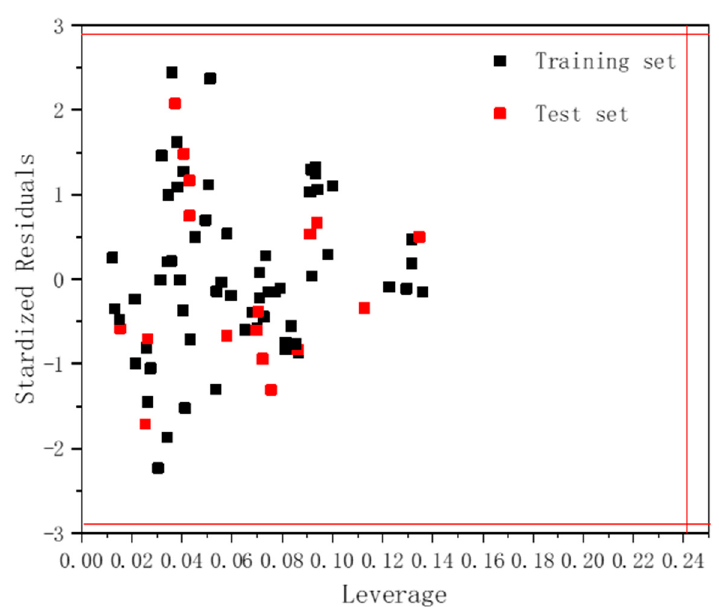
Figure 5. The Williams plot of the training and external test